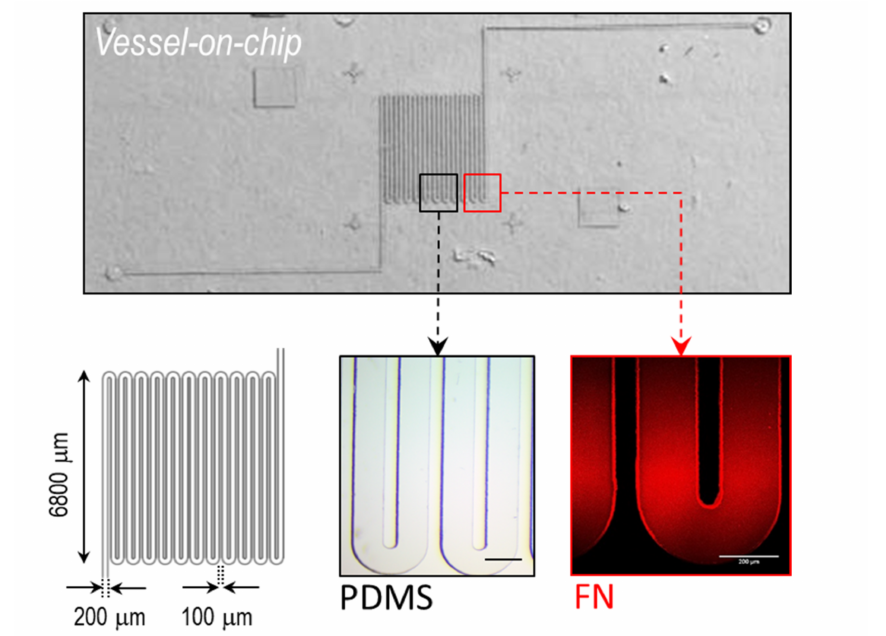
Figure 1. Microfluidic vessel-on-a-chip. ( Upper ) Optical microscopy image of the polydimethylsilox- ane (PDMS) microfluidic chip. ( Lower ) Left—Scheme showing the dimensions of the microchannel; middle and right—magnified image of the fabricated and fibronectin-coated (rhodamine) channel. Scale bar: 200 µ